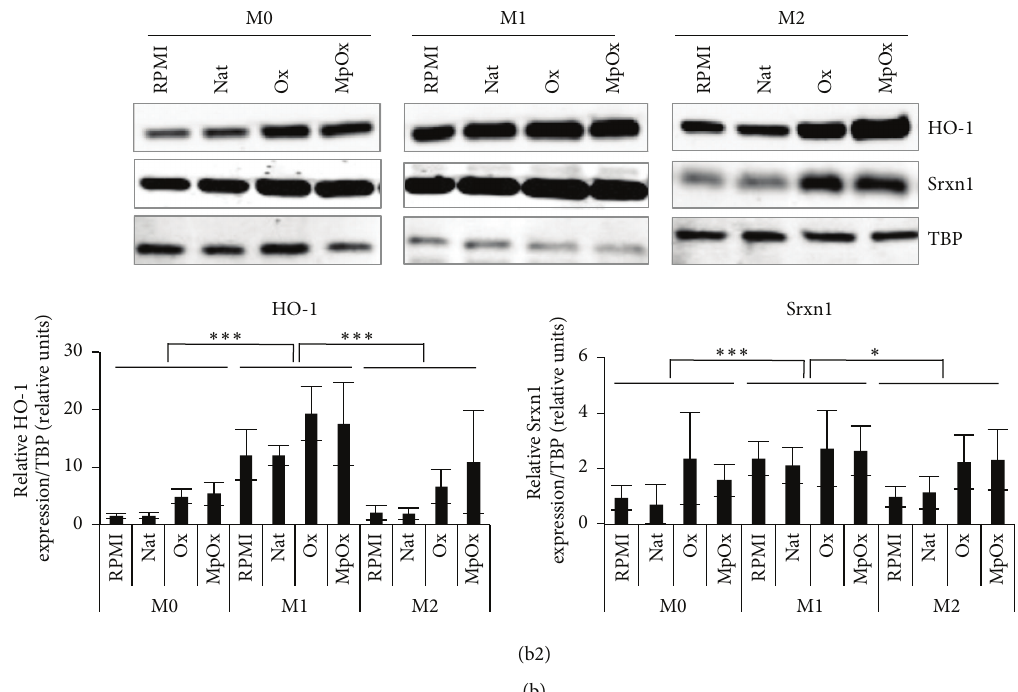
Figure 5: Comparative effects of LDLs on (un)polarized BMDMs. M0, M1, and M2 macrophages were stimulated in the presence or absence (RPMI control) of Nat-LDLs, Ox-LDLs, and MpOx-LDLs for 24 hours (100 𝜇 g/mL). (a) Expression of polarization marker genes at the mRNA level (RT-qPCR). The expression of marker genes was analyzed by RT-qPCR as described in the preceding figures. Data are normalized with TBP used as housekeeping gene and expressed as mean fold induction relatively to M0 cells in RPMI ± SD ( 𝑛 = 5 ). Data were analyzed by a Kruskal-Wallis ANOVA on ranks (except for Arg1 and IL-6 : two-way ANOVA test). (b) Expression of polarization markers at the protein level (ELISA; WB). (b1) Production of secreted IL-6 (M1 marker) in cell culture supernatants assessed by ELISA. Data are expressed relatively per 𝜇 g of protein per well as mean ± SD ( 𝑛 = 3 ). (b2) Expression of HO-1 and Srxn1 assessed by Western blotting. Data are normalized with TBP used as loading control and expressed as mean ± SD ( 𝑛 = 4 ). Results are representative of 4 independent experiments. ANOVA 2: ∗, # 𝑝 < 0.05 ; ∗∗ 𝑝 < 0.01 ; and ∗∗∗, ### 𝑝 < 0.001